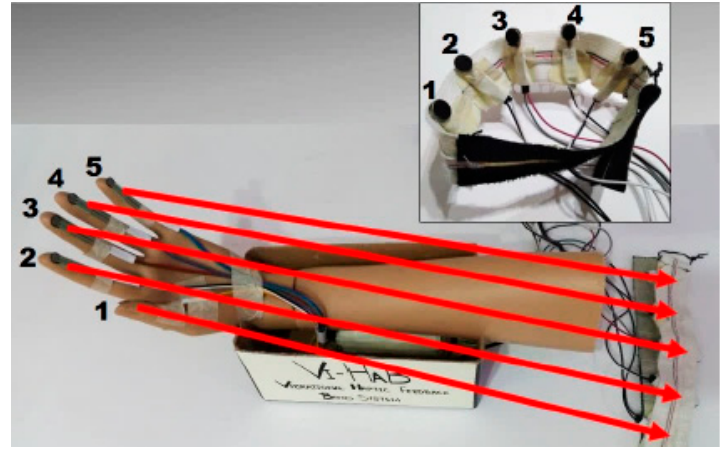
Figure 8. Vi-Hab system with highlighted main components: the wearable band and 5 vibrating motors [56]; a force sensitive resistors (FSR) and related motor are present for each finger of the dummy hand (from 1 to 5, totally five). The wearable band (in the inset) wraps around the upper arm such that each motor falls in line with the natural position of the fingers as shown by the red arrows.